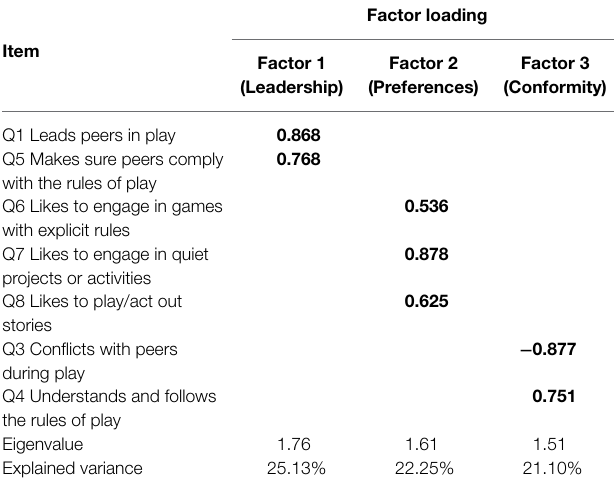
TABLE 2 | Factor loadings for three factor model.